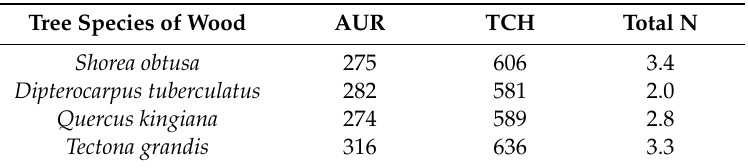
Table 2. Contents (mg / g) of organic chemical components and total nitrogen (N) in wood of four tropical tree species used in pure culture decomposition tests. AUR, acid unhydrolyzable residue; TCH, total